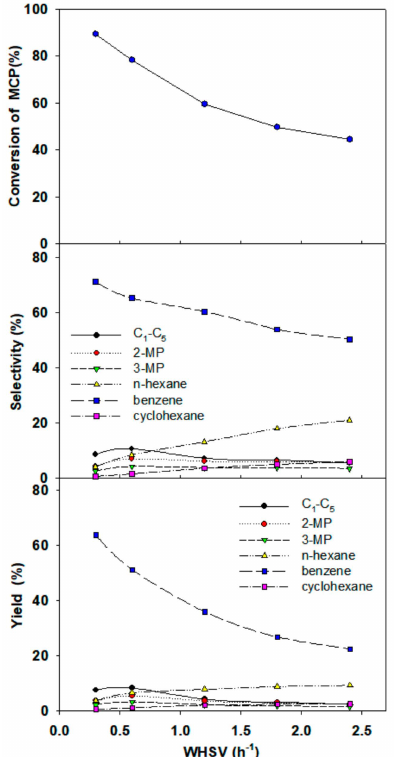
Figure 11. E ff ect of space velocity on conversion, selectivity and yield over Pt / (HZSM-48 + pseudoboehmite,1:1) catalyst (reaction condition: H 2 / MCP (mole / mole) 10, temperature 450 ◦ C,